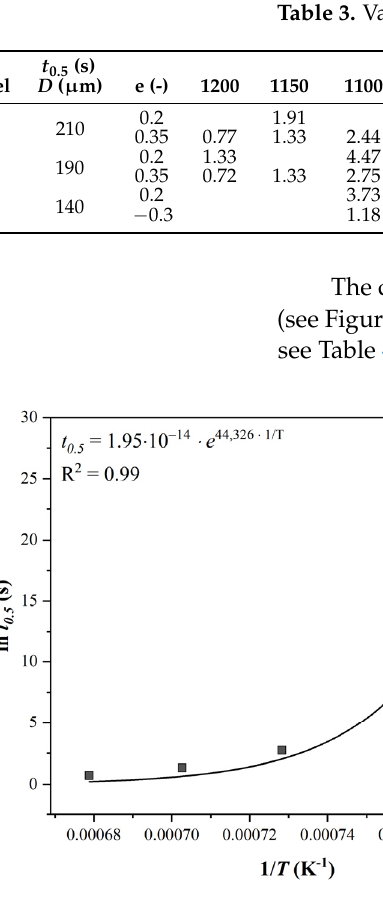
Table 3. Values of t 0.5 in the JMAK equation.